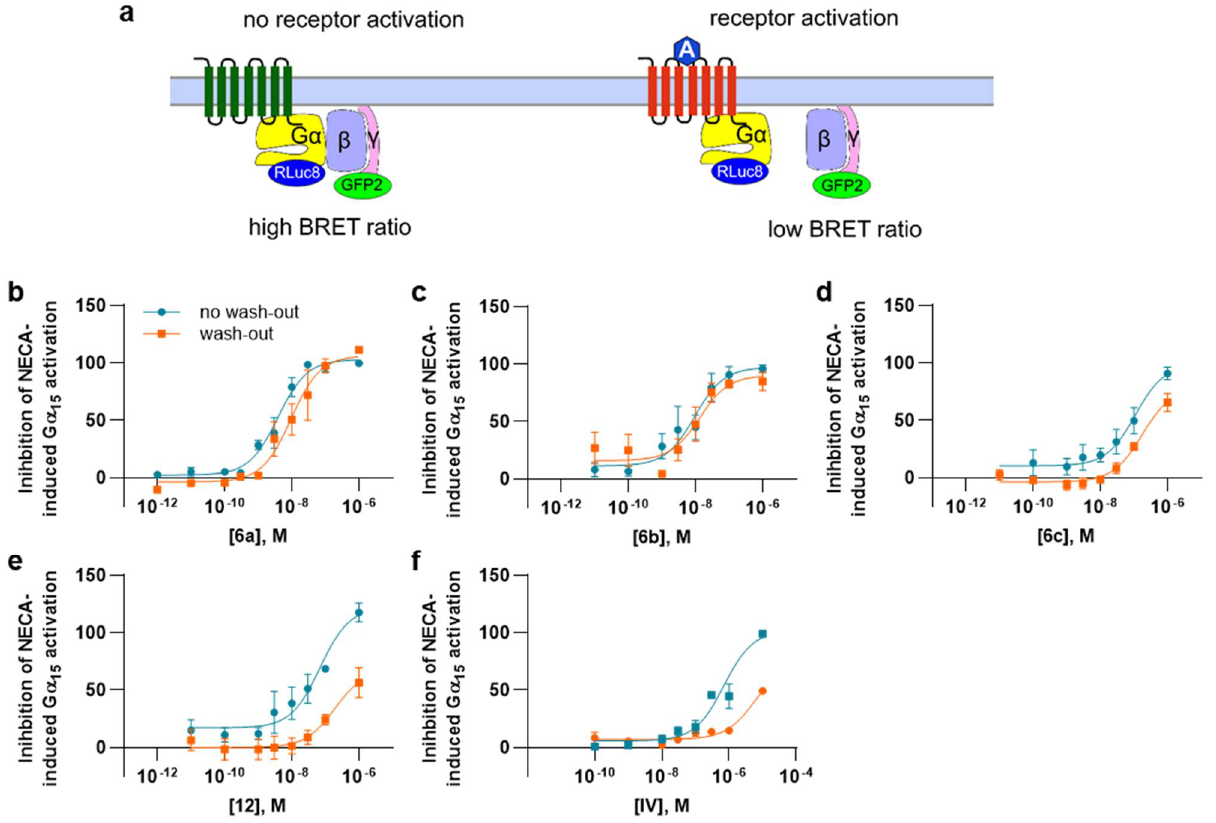
Figure 4. Functional assessment of A 2B AR inhibition by the new antagonists . ( a ) Assay principle of the TRUPATH BRET 2 assay. When the receptor is not activated, the G protein (G α 15 β 3 γ 13 ) is in its inactive trimeric form, where G α 15 -RLuc8 and G γ 13- GFP2 are in close proximity, resulting in a high BRET ratio. When the receptor is activated by an agonist (NECA). the trimer re-arranges, and the BRET ratio decreases due to a larger distance between the probes. ( b – f ) Concentration-response curves of ( b ) PSB-21500 ( 6a ), ( c ) PSB-21501 ( 6b ), ( d ) PSB-21502 ( 6c ), ( e ) PSB-21503 ( 12 ), and ( f ) PSB- 1115 ( IV ) showing the percent inhibition of NECA-induced Gα 15 activation without or after wash-out. Wash-out did not result in significant differences for 6a , 6b , and 6c . In contrast, significantly reduced inhibition of receptor activation was observed after wash-out of 12 and IV .